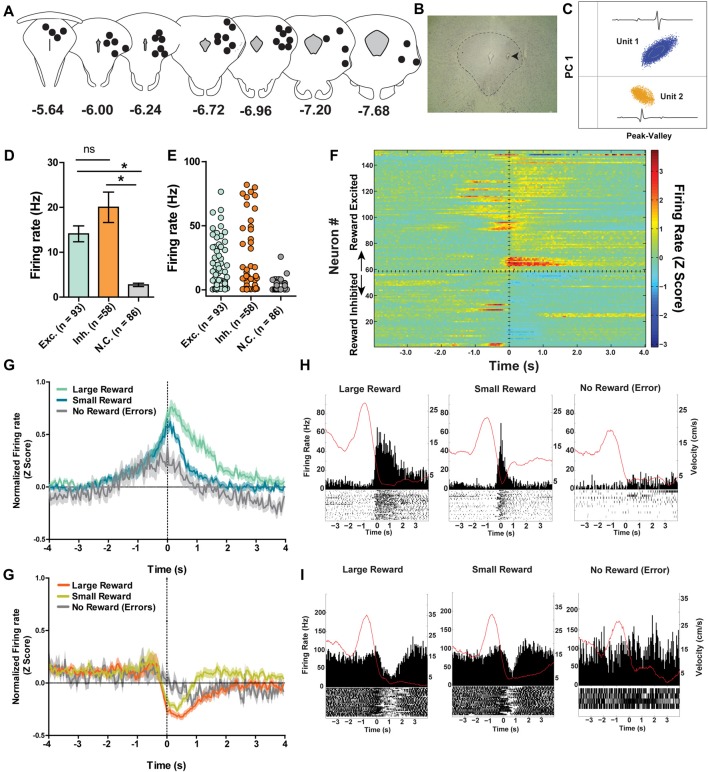
(A) Reconstruction of terminal tetrode locations relative to Bregma (mm). Black dots represent the location of the electrolytic lesion that marked the tetrode location. (B) Example electrolytic lesion in the PAG. (C) Illustration of signals from two simultaneously recorded PAG neurons. (D) A total of 237 individual neurons from seven rats were recorded from the PAG during spatial working memory task performance (see Figure 1A). Individual neurons were sorted into one of three groups: reward excited, reward inhibited, or not significantly reward modulated (Wilcoxon signed rank test, see “Materials and Methods” section). Reward modulated neurons had significantly higher firing rates than non-reward modulated cells (one-way ANOVA, F(2,24) = 21.08, p < 0.0001; Bonferroni’s post hoc comparisons to compare each pair, *indicates p < 0.05). Exh. = Reward Excited, Inh. = Reward Inhibited, N.C. = not correlated to reward. Error bars represent ±SEM. (E) Each dot represents the mean firing rate of an individual neuron from each group. (F) Heatmap of normalized firing rates of all reward responsive neurons. Time 0 indicates onset of large reward encounters. Dotted line separates the reward excited and reward inhibited groups. As observed, some reward responsive neurons showed changes in firing patterns before reward onset began while others increased or decreased firing after reward encounters. (G) Normalized firing rates of reward excited neurons in response to large, small and no rewards. Time 0 indicates onset of reward encounters for large and small rewards or expected reward location for error trials. The solid line indicates mean firing rate within 50 ms time bins; the shaded region around each line represents ±SEM. The magnitude of reward responses scaled with reward magnitude (see “Results” section). (H) Peri-event time histograms (PETHs) of a reward excited neurons’ responses to large, small, and no rewards. Left Y axis represent the mean firing rate (Hz) over all events; right Y axis is mean velocity (cm/s), represented by the red line. (I) Normalized firing rates of reward inhibited neurons in response to large, small, and no rewards. (J) PETHs of a reward-inhibited neurons’ responses to large, small and no rewards. *p ≤ 0.05; ns, not significant.